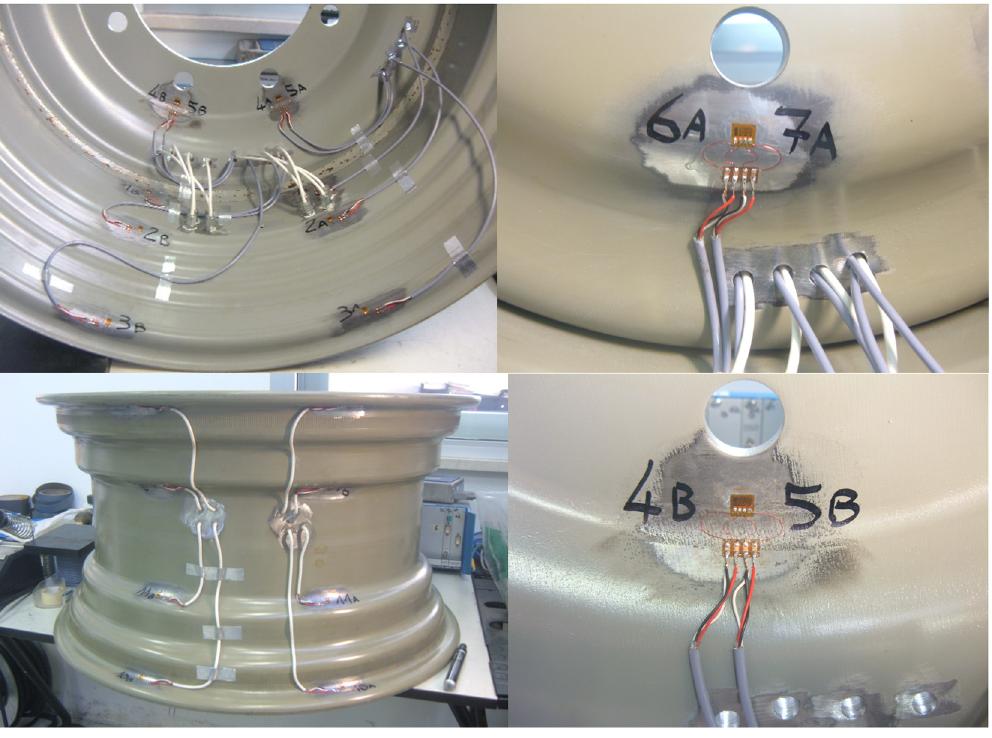
Figure 3. Strain gauges applied to the rim and folder of the